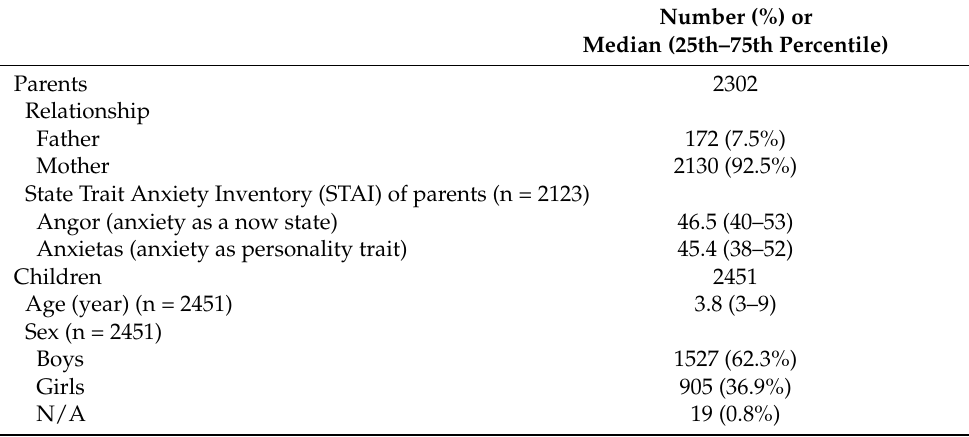
Figure 1. Flowchart of the participant selection process. Table 1. Based information of parents and children 1 .